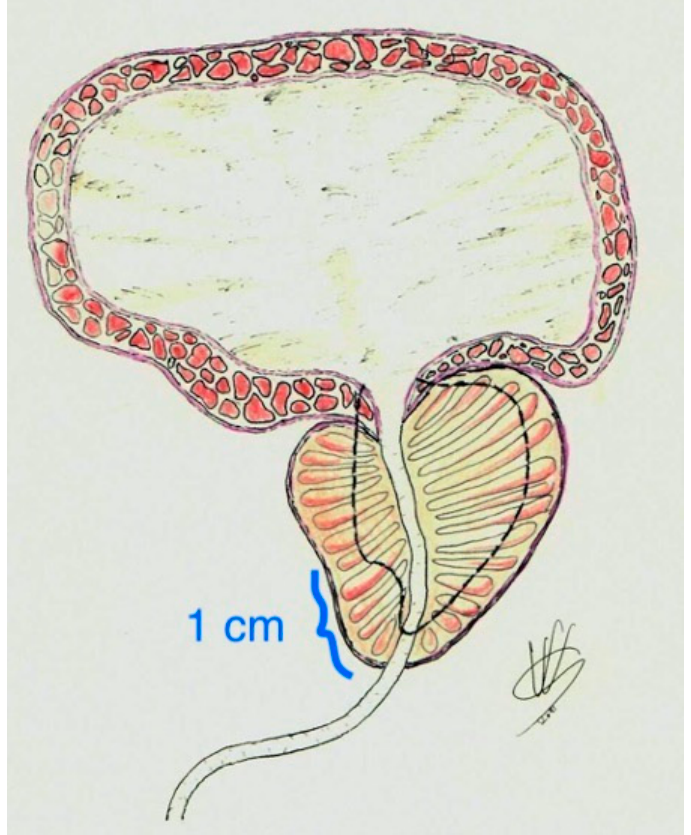
Figure 5. Graphical representation of the adenoma Cap HoLEP technique.